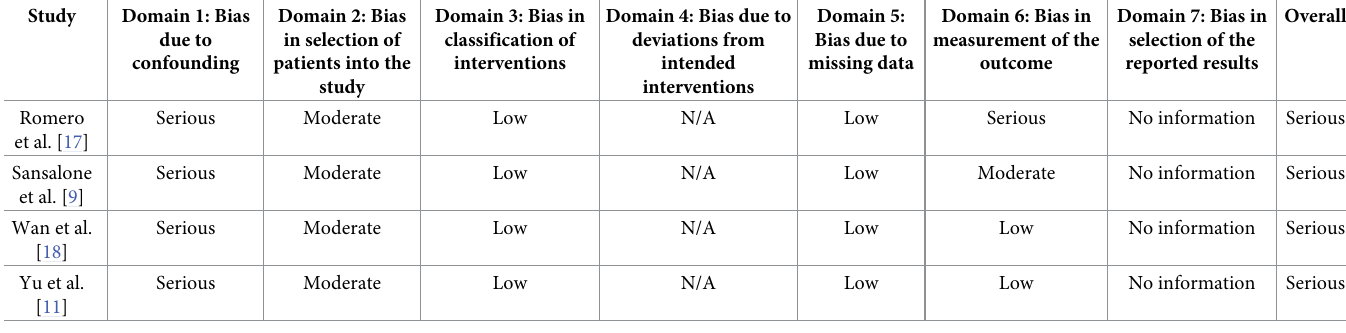
Table 2. ROBINS-I quality assessment of included